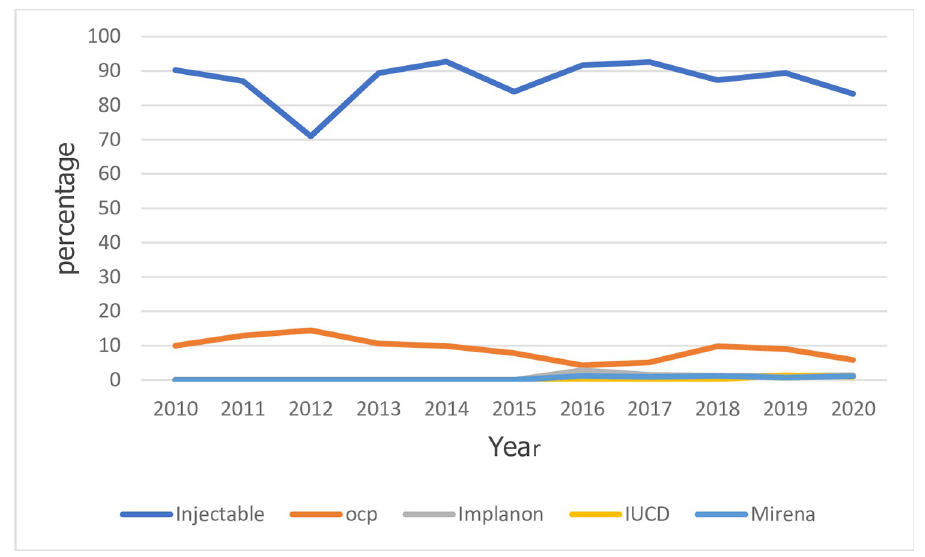
Fig 3. Graphs showing the annual proportion of the various contraceptive uptake within the facility.